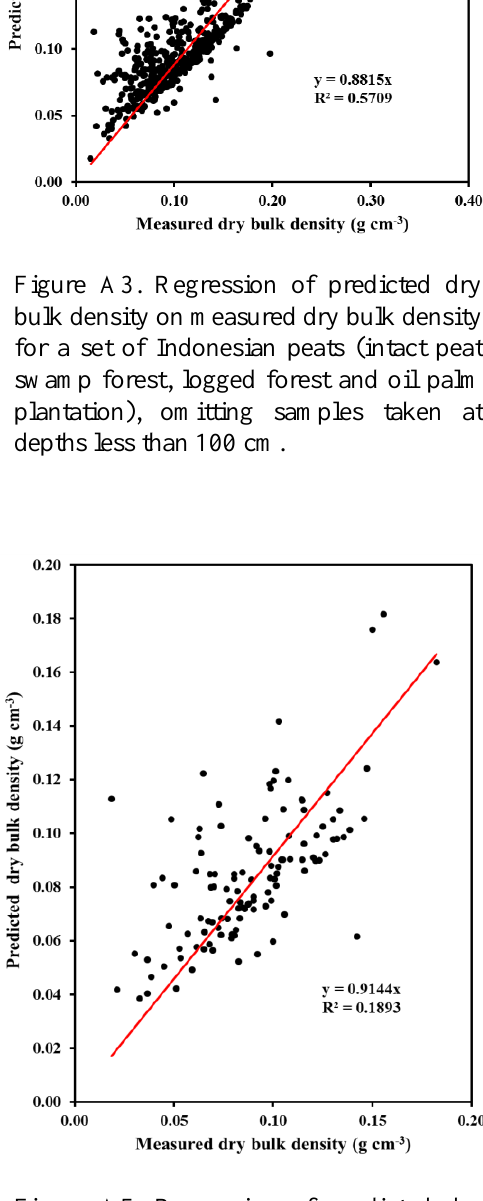
Figure A5. Regression of predicted dry bulk density on measured dry bulk density for a set of Indonesian logged forest peats, omitting samples taken at depths less than 100 cm. Standard error of observations = 0.0231, P < 0.001.